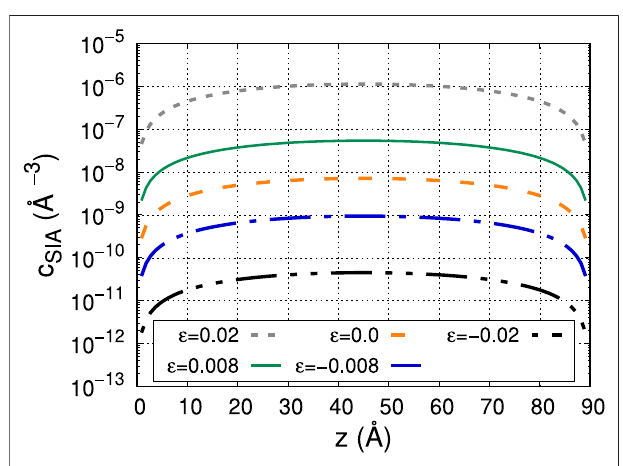
FIGURE7| Steady-stateconcentrationofSIAs inamaterial slabof90 Å inthicknessobtainedbythesolutiontothediffusionequationgivenby Eq.5 at different levels of biaxial